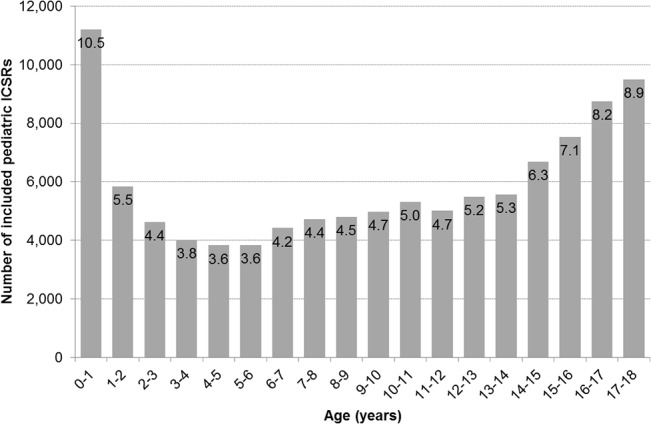
Number of reported ICSRs by age.Within the bars the proportion of ICSRs within this age-stratum of the total reported pediatric ICSRs is given.